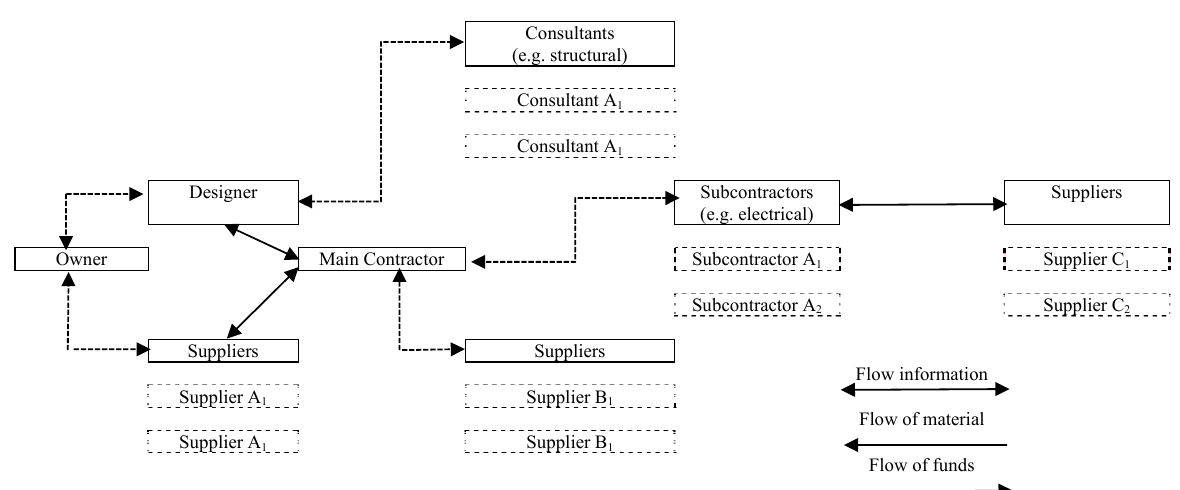
Fig. 1. A typical construction supply chain (Studer & De Brito Mello,